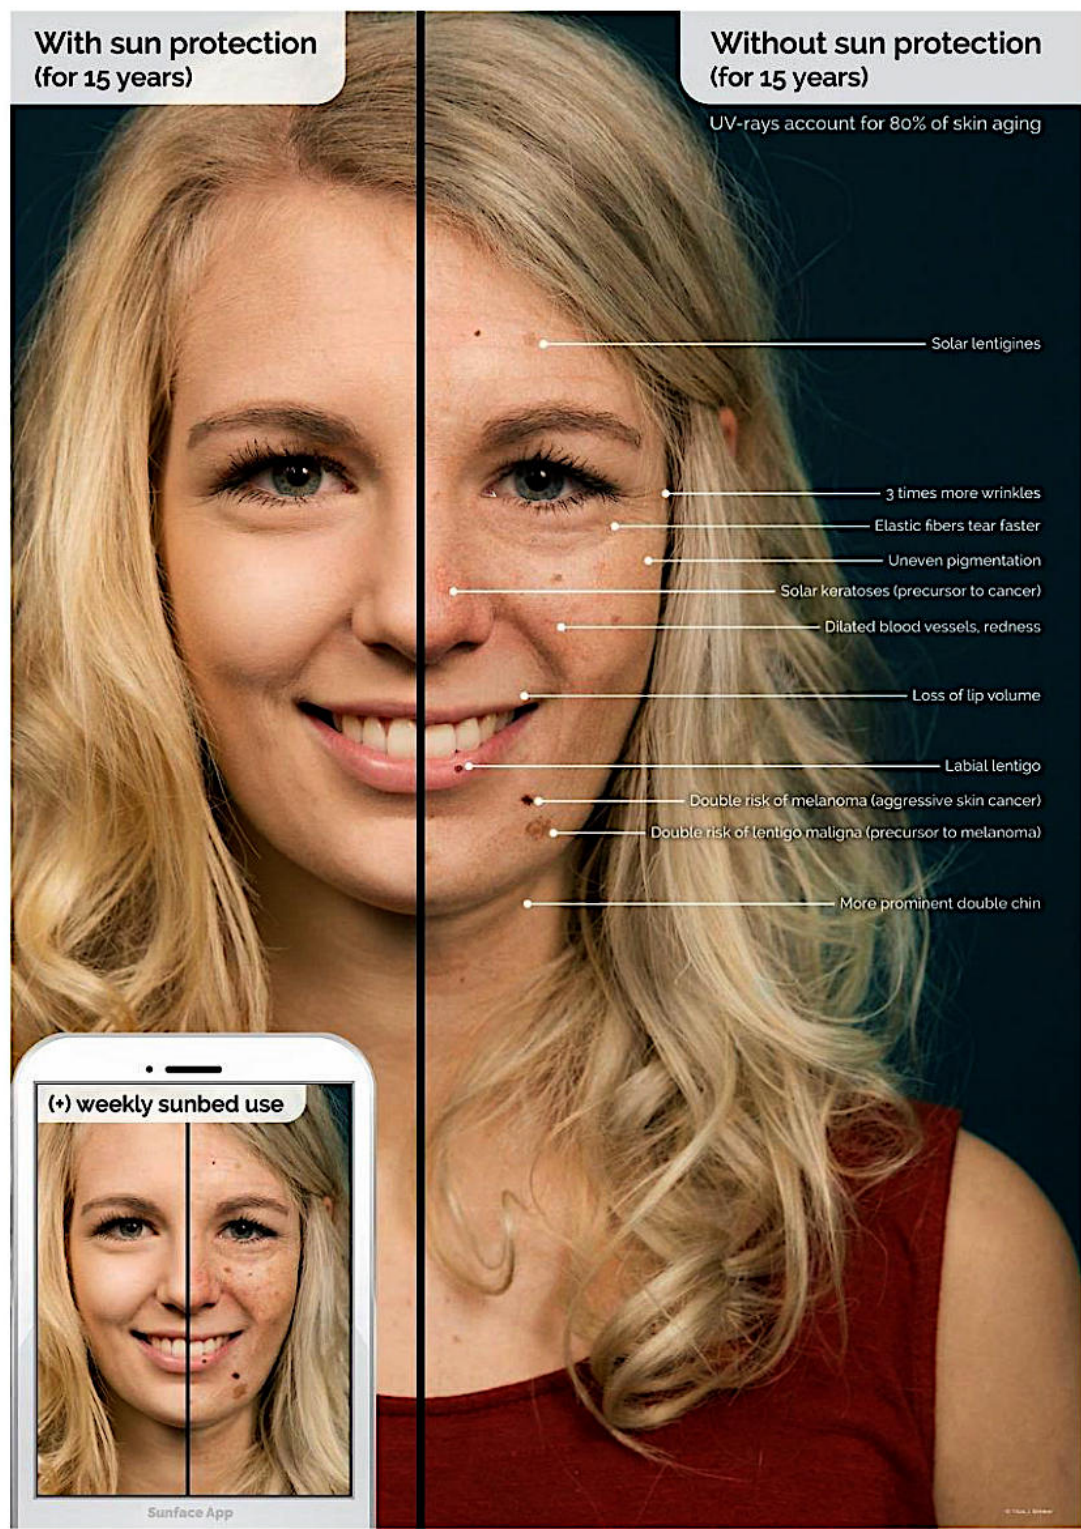
Figure 6. Explanatory graphic of the effects within the